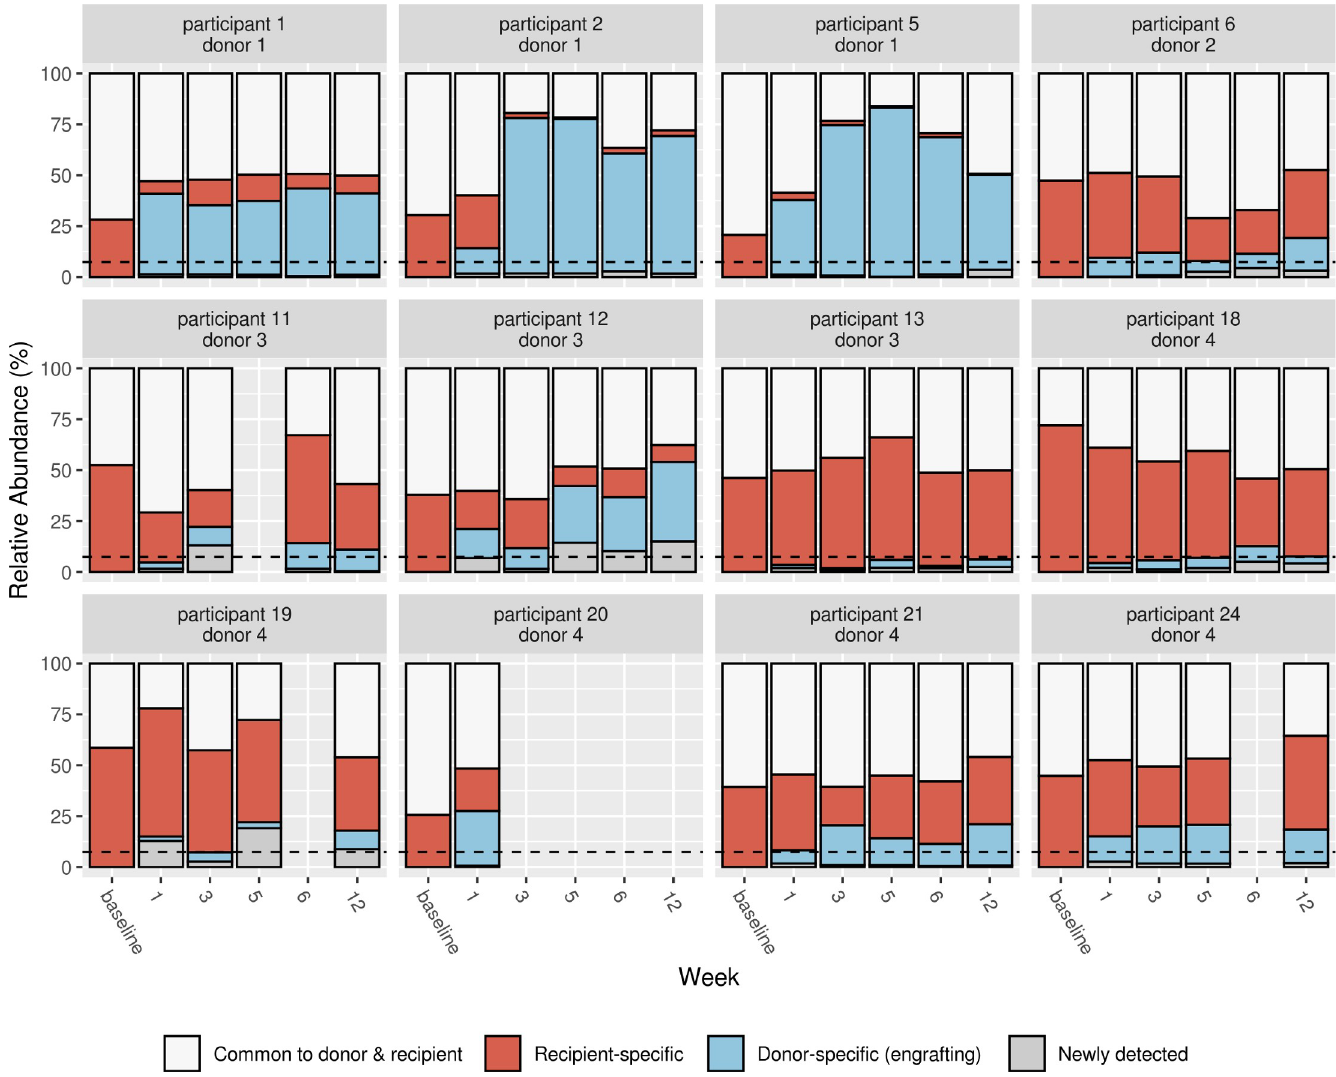
Fig 5. Proportion of bacterial amplicon sequence variants (ASVs) for each fecal microbiota transplantation (FMT) participant and timepoint hypothesized to originate from the participant’s or donor’s microbiome. Each facet is labeled by participant (first line) and paired donor (second line). Red bars indicate ASVs present in participant baseline and follow-up samples, and thus thought to be native to the participant. ASVs originating from the donor and not detected in paired participant baseline samples, and thus thought to be engrafting ASVs, are shown in blue. ASVs only observed following treatment and not seen in paired donor material are categorized as newly detected and displayed in gray. ASVs shown in white were observed in both paired donor and baseline recipient samples, and thus we were unable to resolve whether the ASVs at post-dosing timepoints came from strains native to the participant or donor material. The 75th quartile of newly detected ASVs across post-dosing placebo participant samples is delineated by a dotted line for